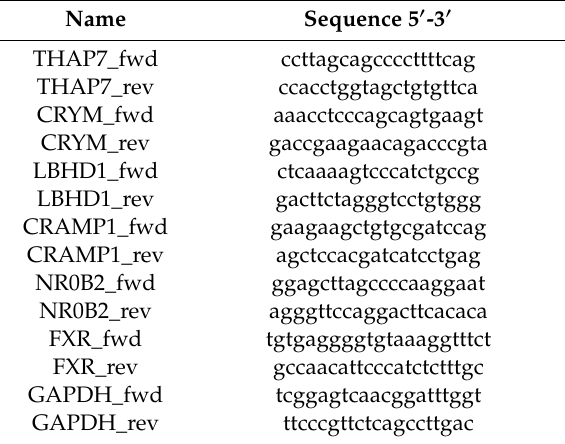
Table 1. Name and sequence of qRT-PCR primers used in this